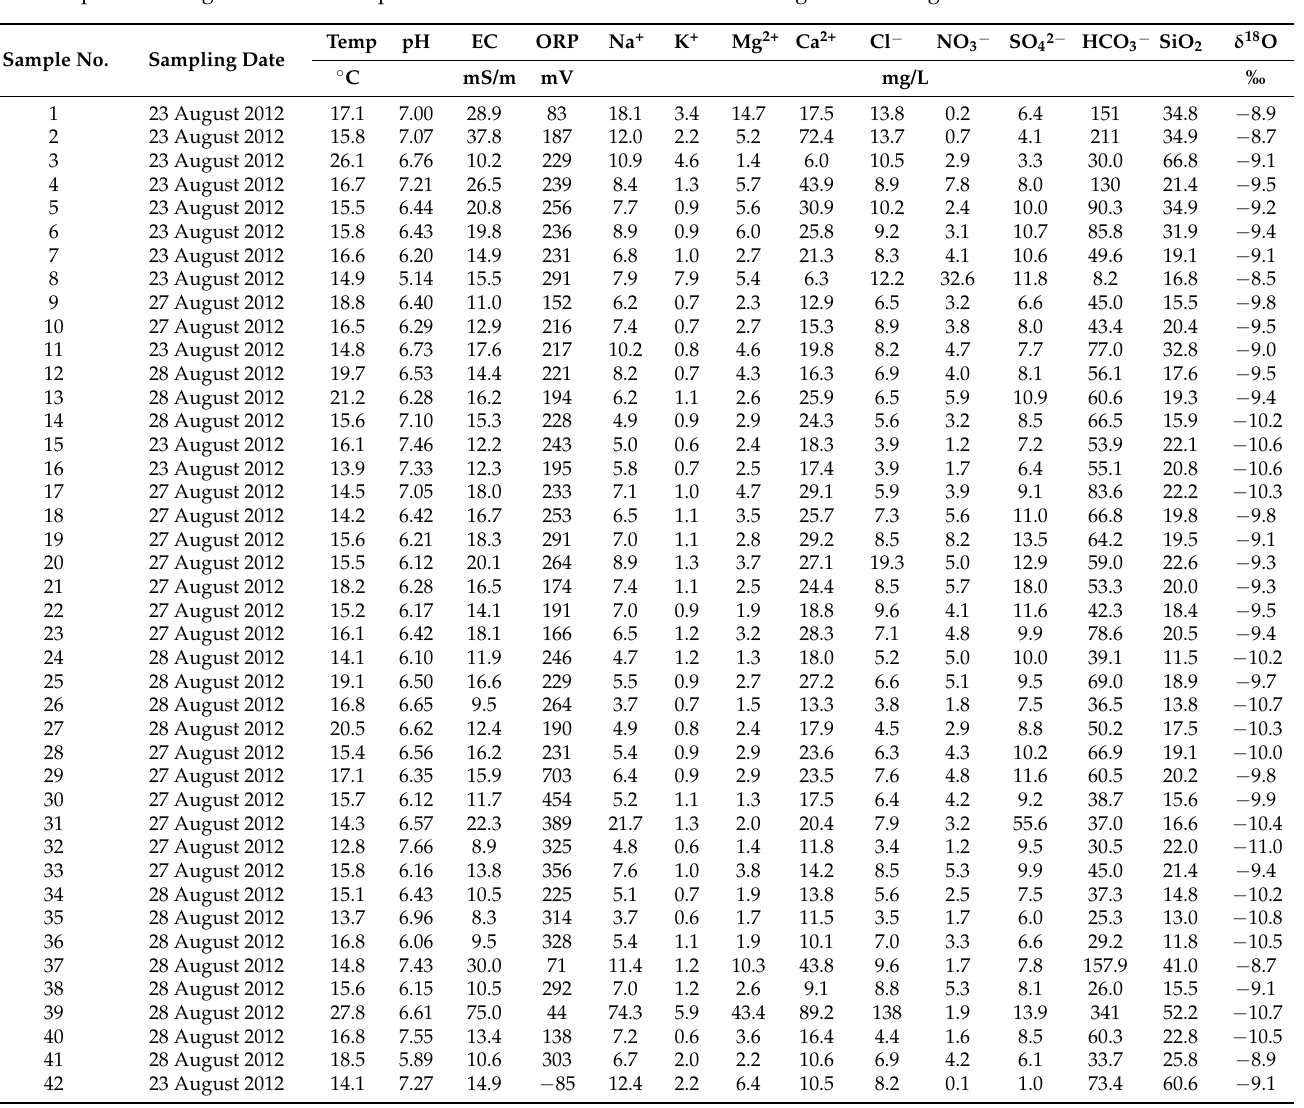
Table 7. Water temperature, pH, electric conductivity (EC), oxidation–reduction potential (ORP), chemical, and δ 18 O composition for groundwater samples in the Sho River alluvial fan on 23 August to 28 August 2012. Sample